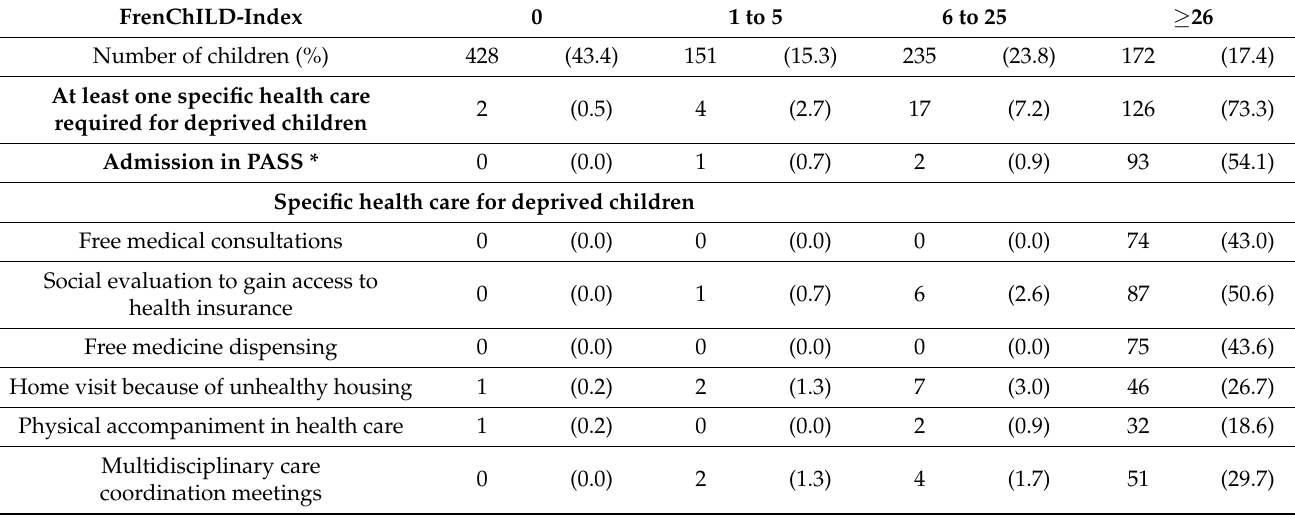
Table 2. Frequency of specific health care for deprived children per French Child Individual-Level Deprivation Index (FrenChILD-Index)